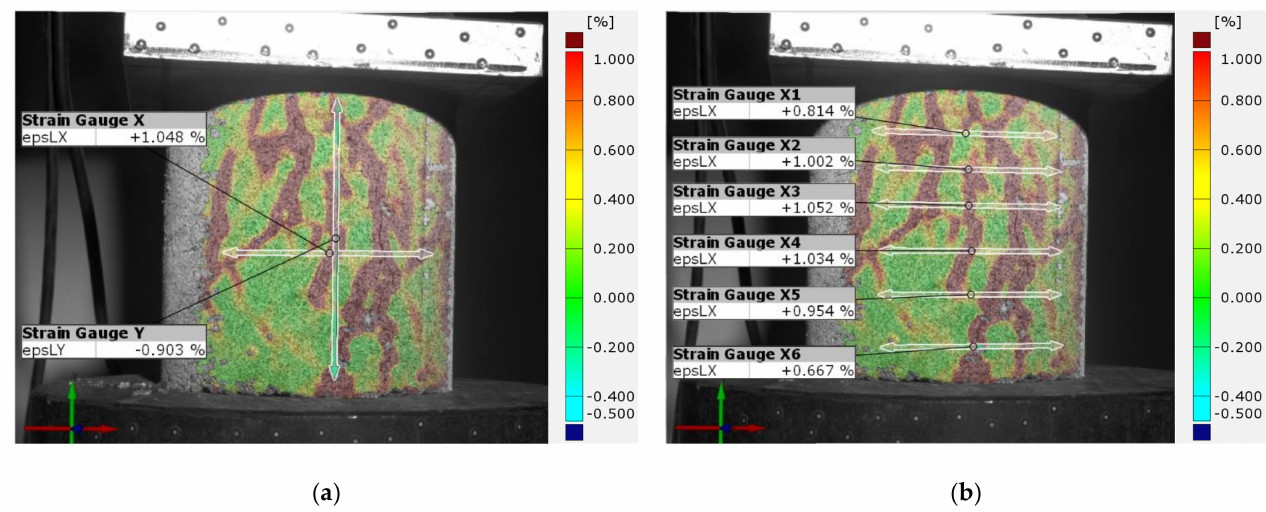
Figure 11. Example of placing virtual strain gauges on the sample surface: ( a ) measurement in perpendicular planes; ( b ) measurement in parallel planes—measurement of lateral strains in planes arranged at different heights of the sample.